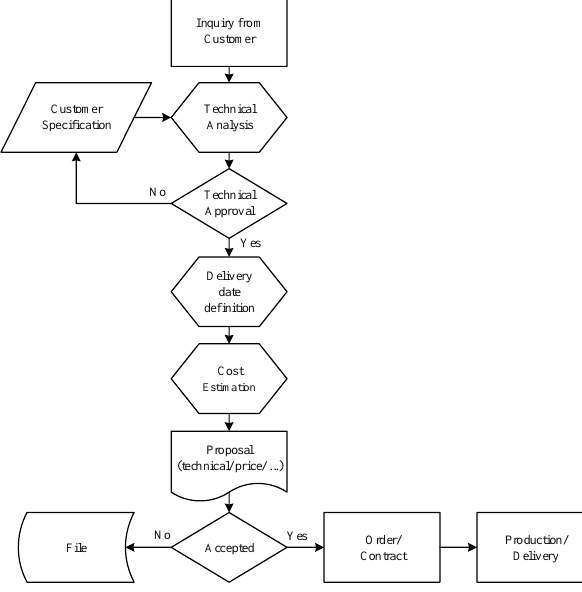
Fig. 1: Bidding process in ETO manufacturing, adapted from [3,14] Figure 1: Bidding process in ETO manufacturing, adapted from [3,